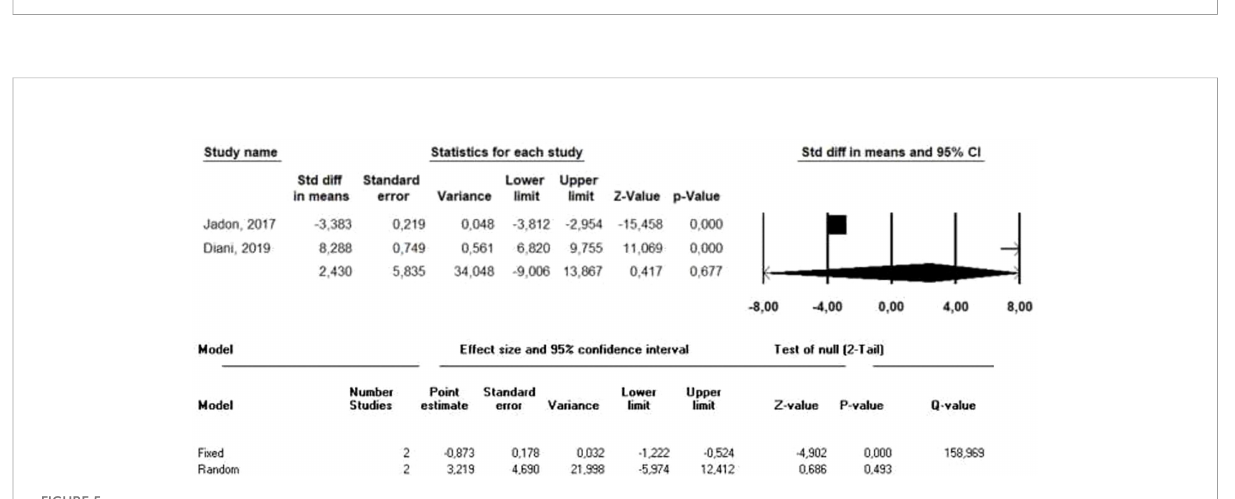
FIGURE 5 Forest plot of difference in Dkk-1 levels means between PsA and HC in